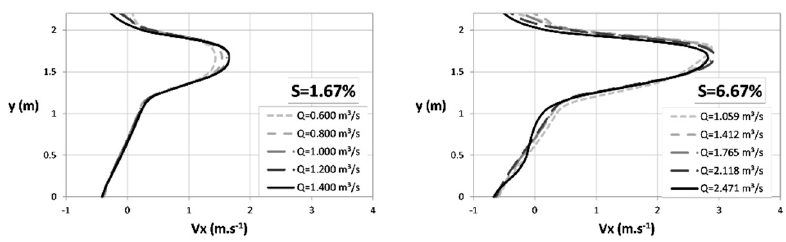
Figure 7. Longitudinal velocities, Vx, in cross section I (x = 0.6 m, Figure 3), in a plane at z/h = 0.4, for design D1, with slopes of 1.67% and 6.67%, and different discharges